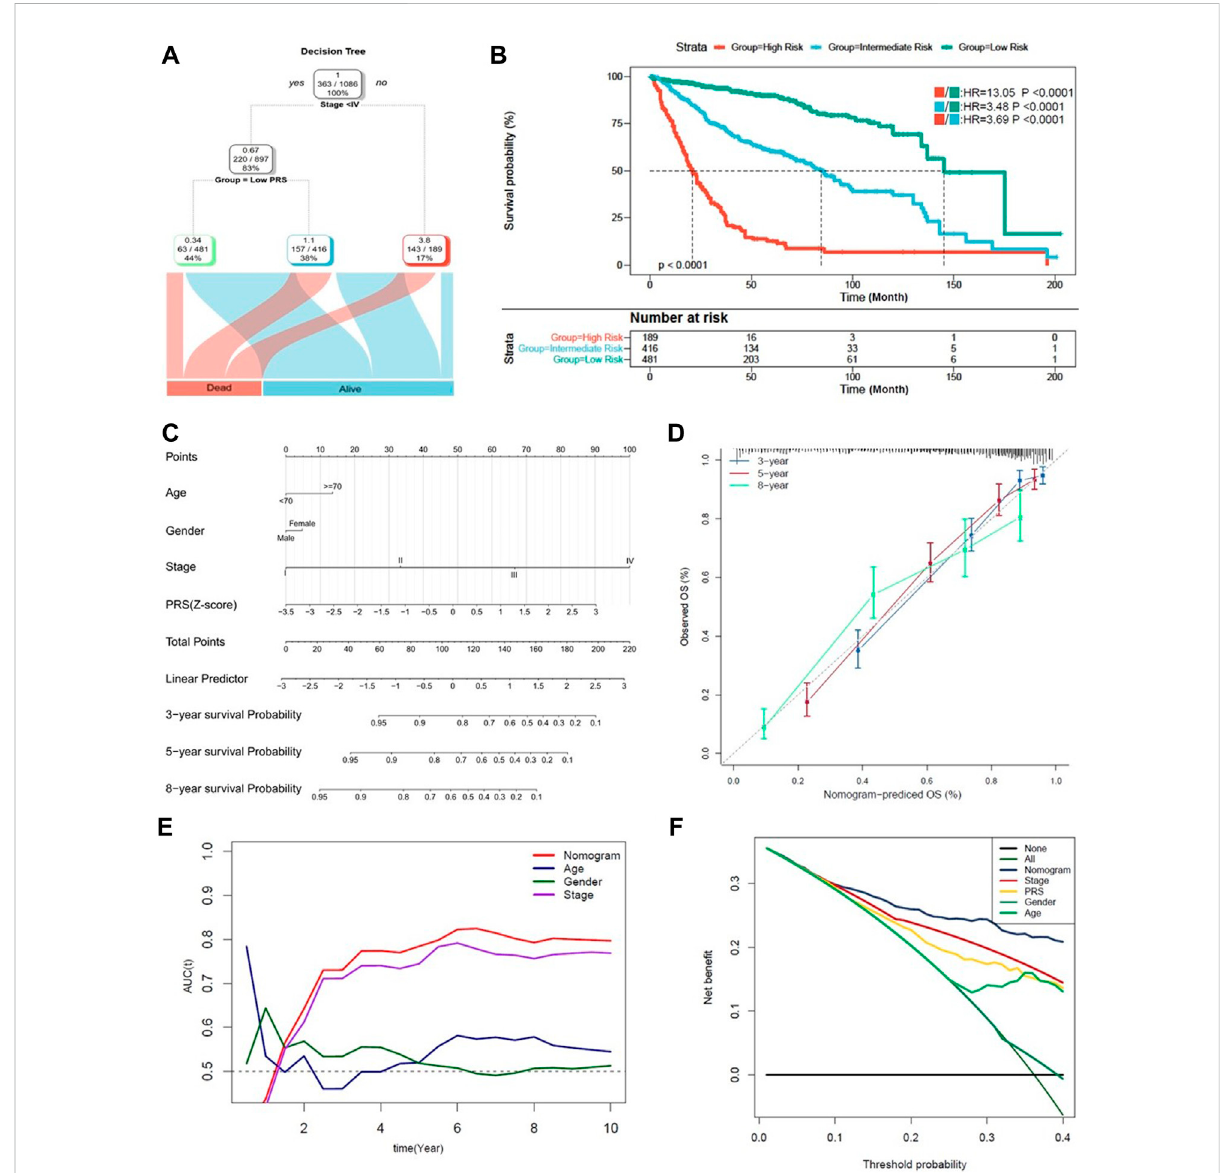
FIGURE 7 Combination of the pyroptosis signature and clinicopathological features improves risk strati fi cation and survival prediction. (A) A decision tree wasconstructedto improveriskstrati fi cation. (B) Performanceofthedecision tree. (C) Anomogramwasconstructedtoquantifyriskassessmentfor individual patients. (D) Calibration analysis indicated a high accuracy of survival prediction. (E,F) tROC analysis and decision curve analysis (DCA) demonstrated that the nomogram was the most stable and powerful predictor for OS among all the clinical